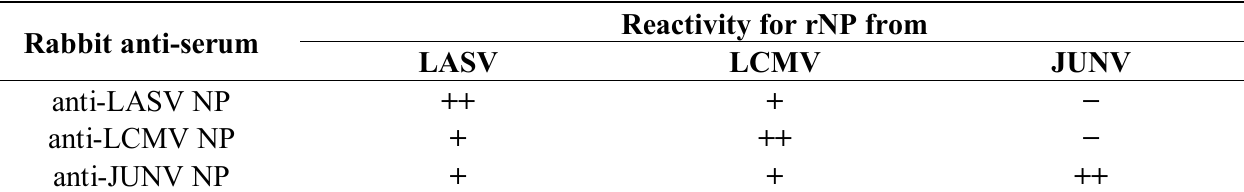
Table 1. Anti-serum reactivity for rNPs of different arenaviruses in IgG